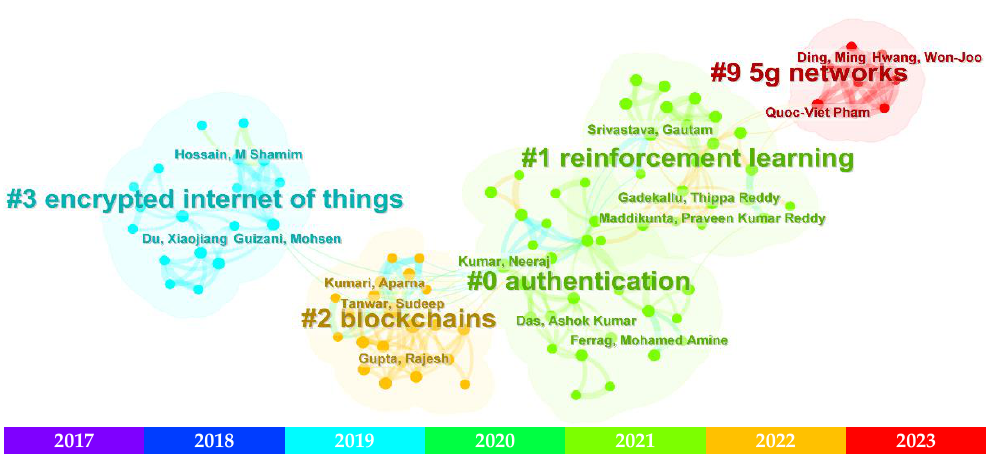
Figure 7. Largest co-authorship clusters in the subject field.